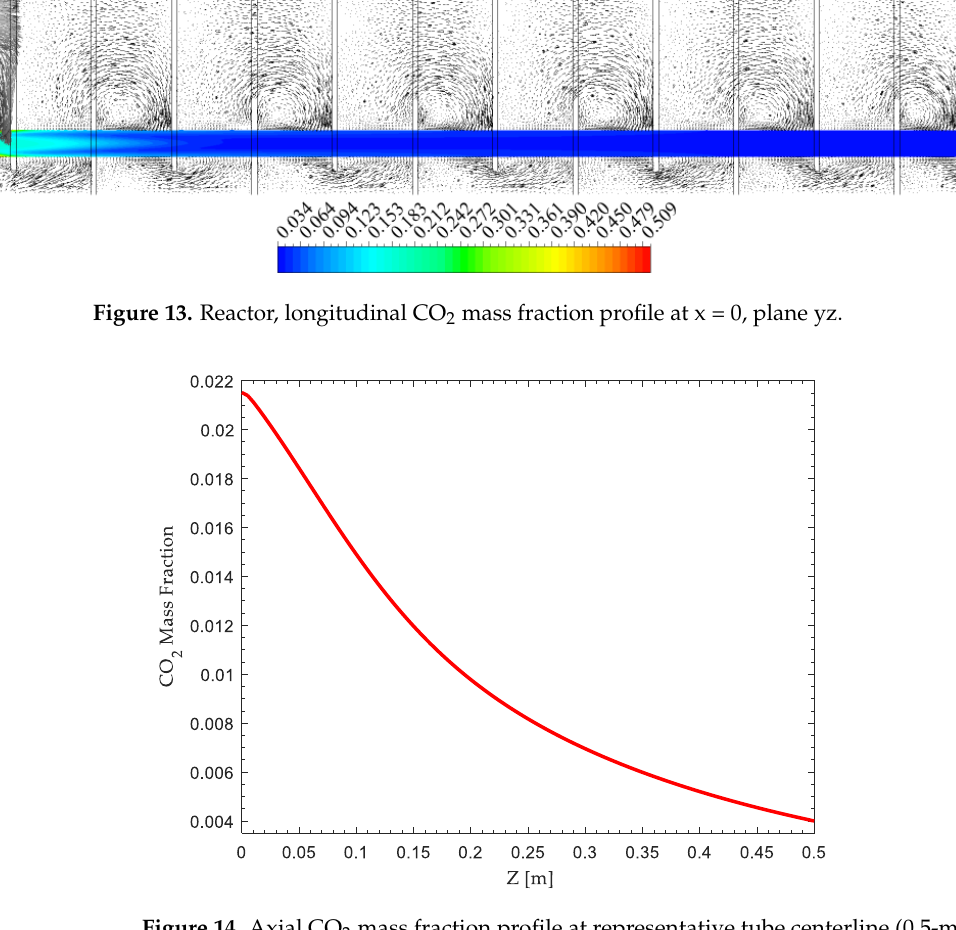
Figure 15. Axial temperature profile at representative tube centerline (0.5-m reactor module) under 7-m 3 /h thermal oil feed rate. 4. Conclusions In this study, the relevance of design features and coolant types on a fixed bed mul- ti-tubular reactor were evaluated through a CFD-based methodology. A comprehensive disk and doughnut design was used for parametric studies involving thermal oil and molten salts for four different coolant flow rates. The adopted kinetics parameters can satisfactorily represent the hydrogenation of CO 2 under the considered operational con- ditions, with a maximum error of 20% at tube inlet. Moreover, hot spot position is accu- rately predicted with a 5% error between numerical and experimental data. CFD-calculated heat transfer coefficients coincide with Gnielinski correlation for a cool- ant mass flow range of 1.7 – 4.6 kg/s (7 – 18 m 3 /h for thermal oil) with a maximum error of 10%. Tube to coolant heat transfer coefficients calculated from empirical correlations